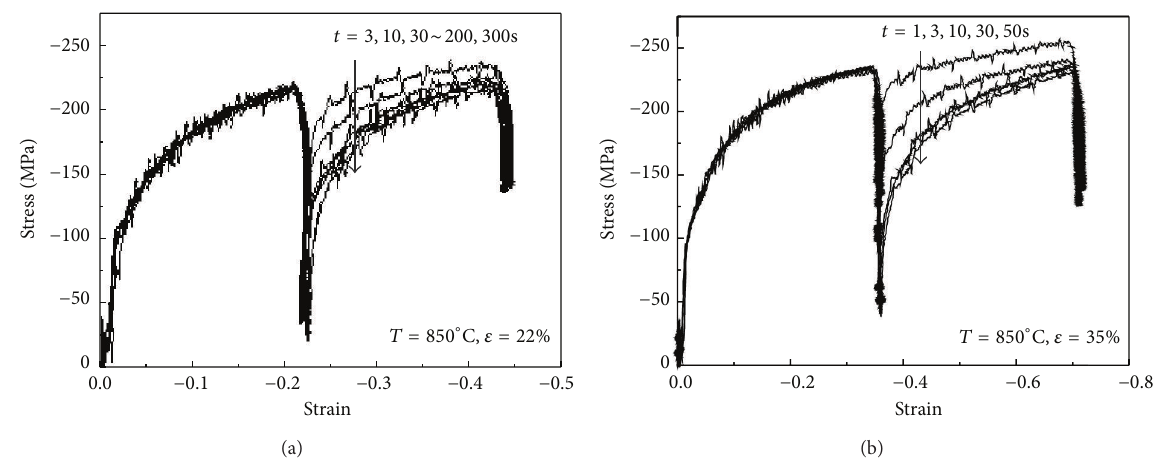
Figure 1: The stress-strain curves in the double compression tests. (a) True strain 𝜀 = 22%; (b) true strain 𝜀 = 35%.